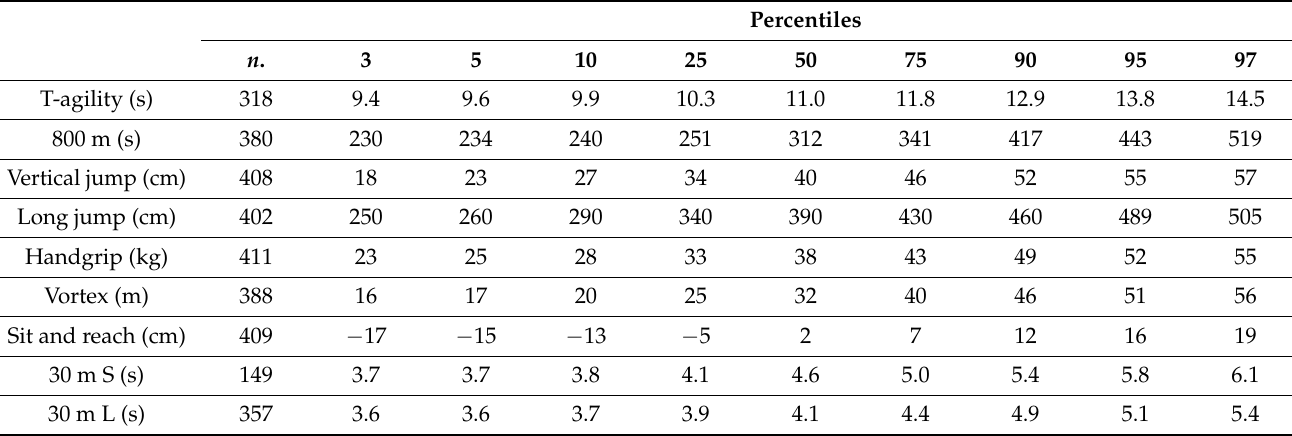
Table 4. Fitness test percentiles for males in the second class of the high